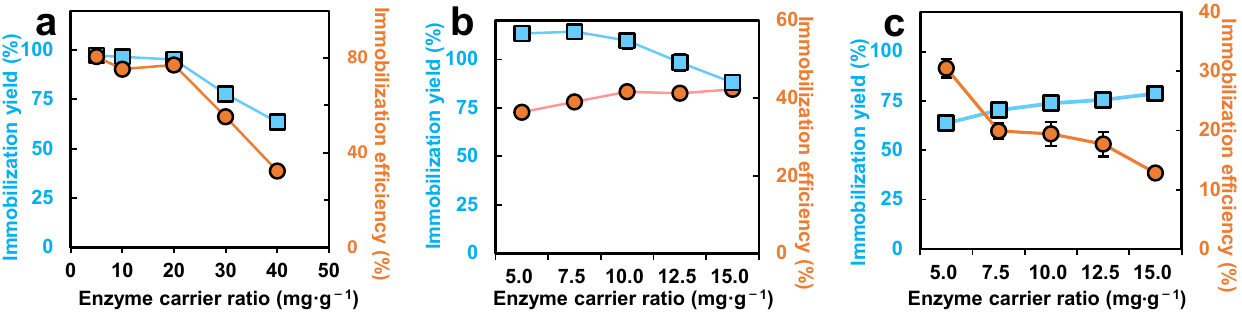
Figure 4. The effect of the ratio of enzymes and carrier on the immobilization of enzymes (blue rectangle: immobilization yield, yellow sphere: immobilization efficiency, a: FLS, b: ADH, and c: NOX).